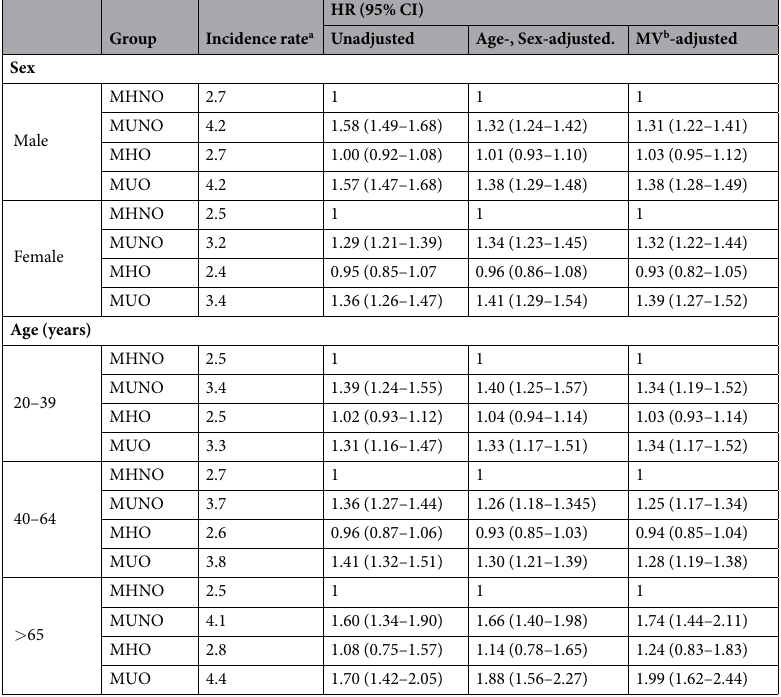
Table 3. Association between metabolic status and incident psoriasis according to sex and age. a per 1000 person-years. b MV includes age, sex, smoking, alcohol drinking, exercise, and income. HR, hazard ratio; CI, confidence interval; MHNO, metabolically healthy, non-obese; MUNO, metabolically unhealthy, non-obese; MHO, metabolically healthy, obese; MUO, metabolically unhealthy,